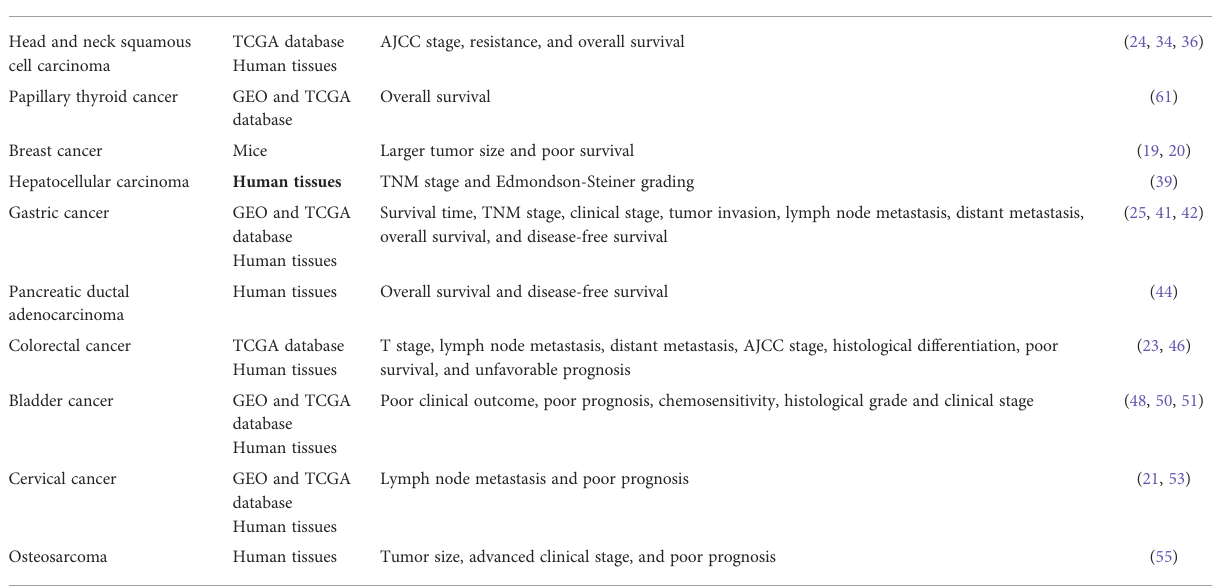
TABLE 2 Clinical signi fi cance of MIR100HG in